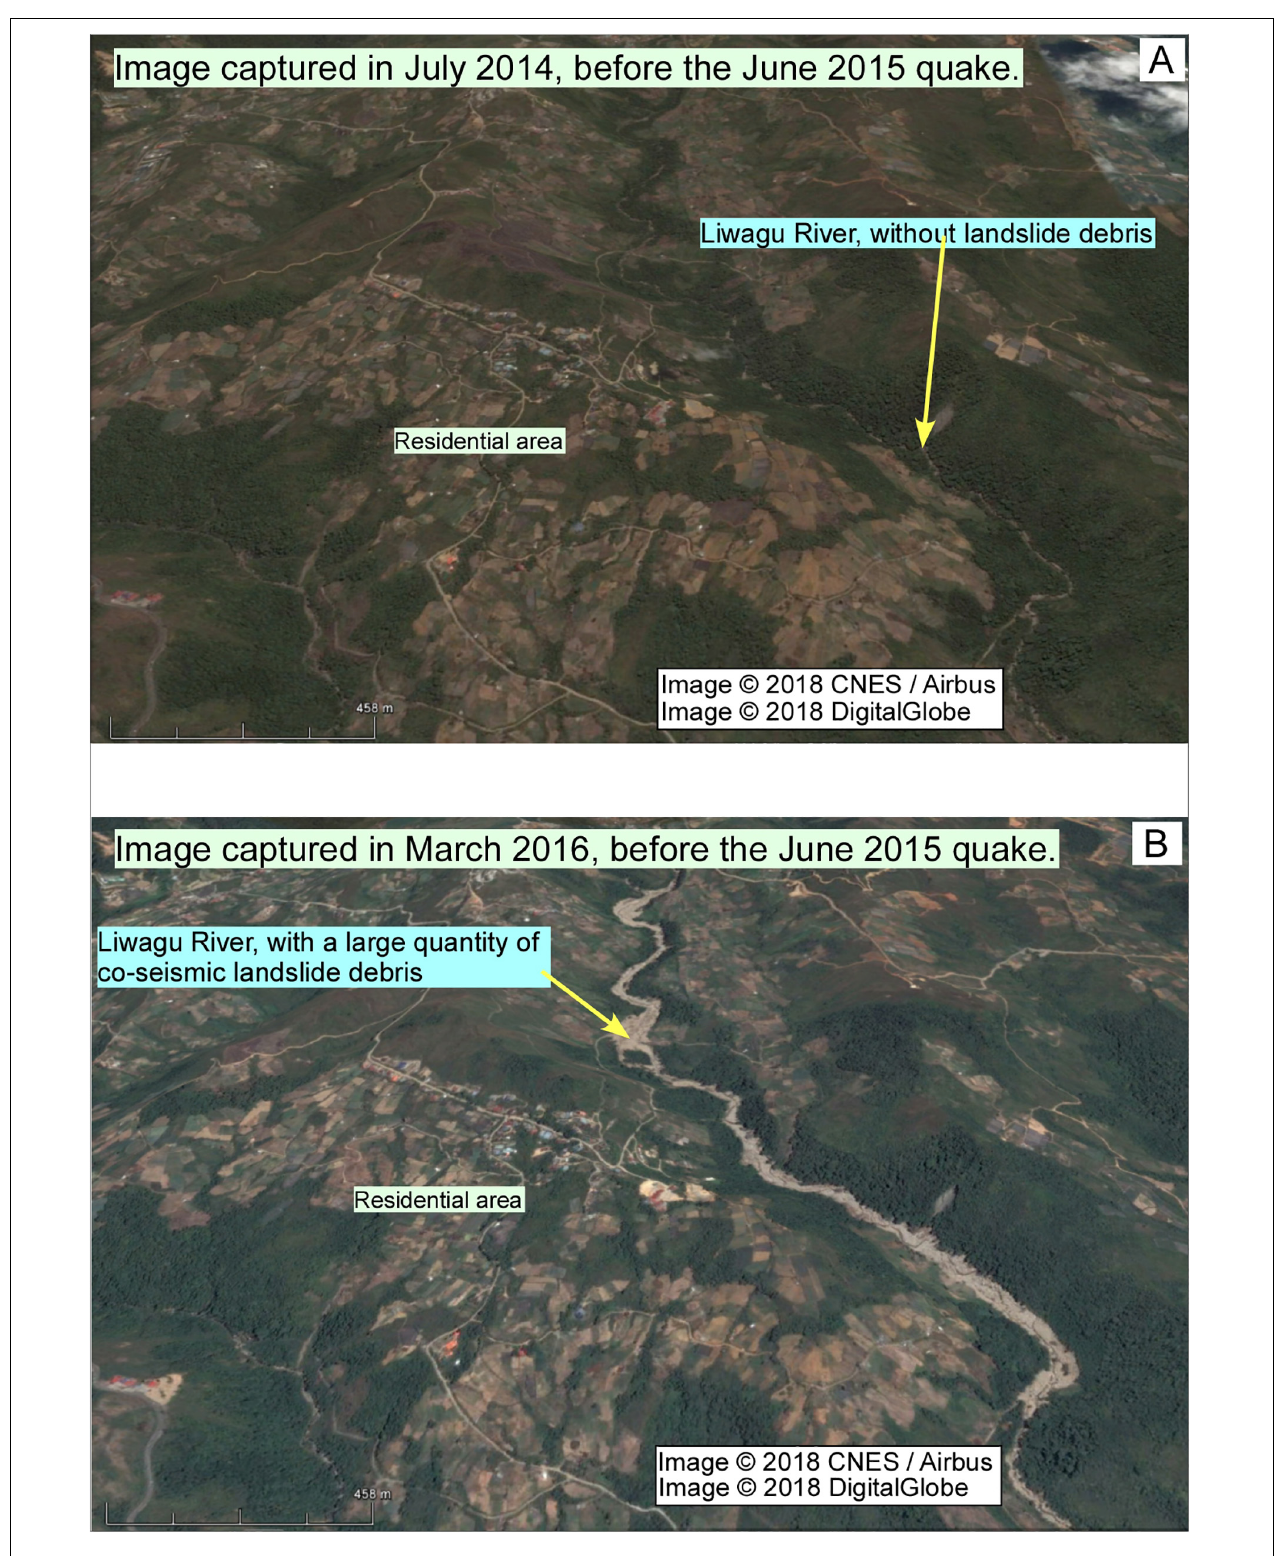
FIGURE 8 | Google satellite images show the scenes captured before (A) and after (B) the June 2015 quake in Sabah. The changes in Liwagu River are highlighted. The filling on the river bed are the remains of the debris that was derived from the earthquake induced landslides in the Mt. Kinabalu region. The debris filled river makes it vulnerable to future fluvial